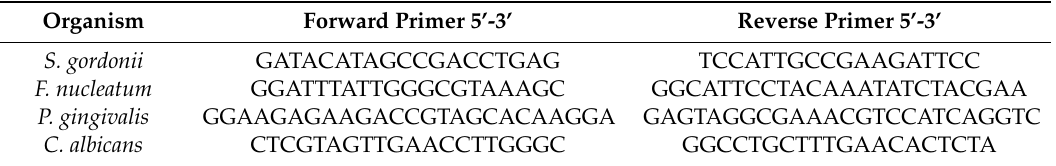
Table 1. Primer sequences used in this study for compositional analysis of multi-species biofilm models.